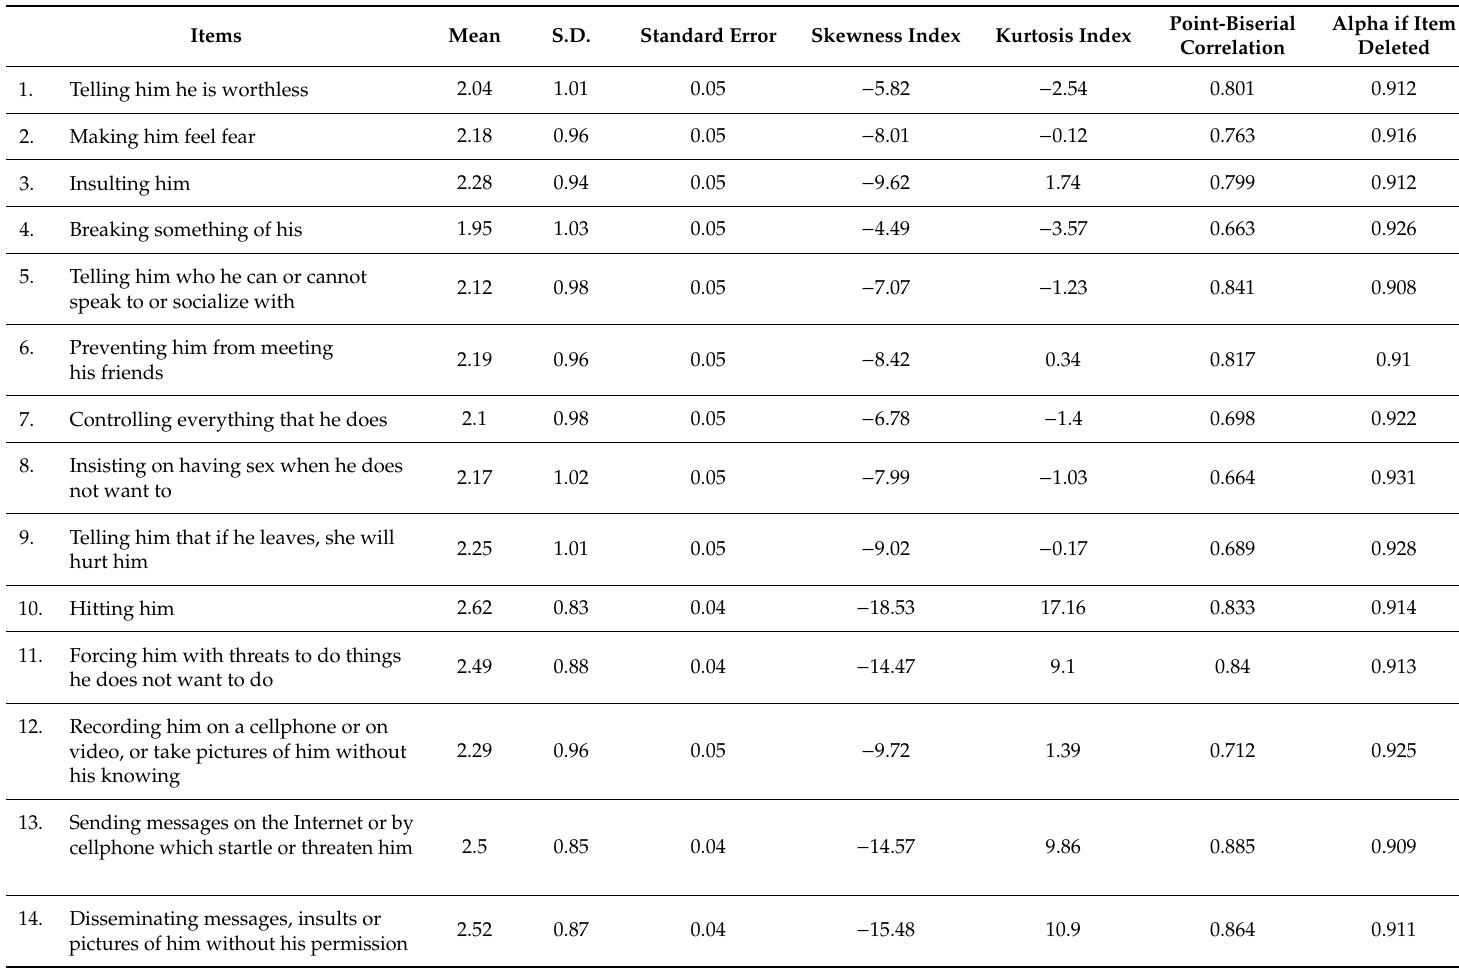
Table 2. Descriptive statistics, asymmetry and kurtosis indices, and biserial-punctual correlation for each item from the di ff erent subscales of the Questionnaire of Perception of Inter-Partner Violence from girl-to-boy. Items from 1 to 7 measure emotional abuse, items from 8 to 14 measure multiple